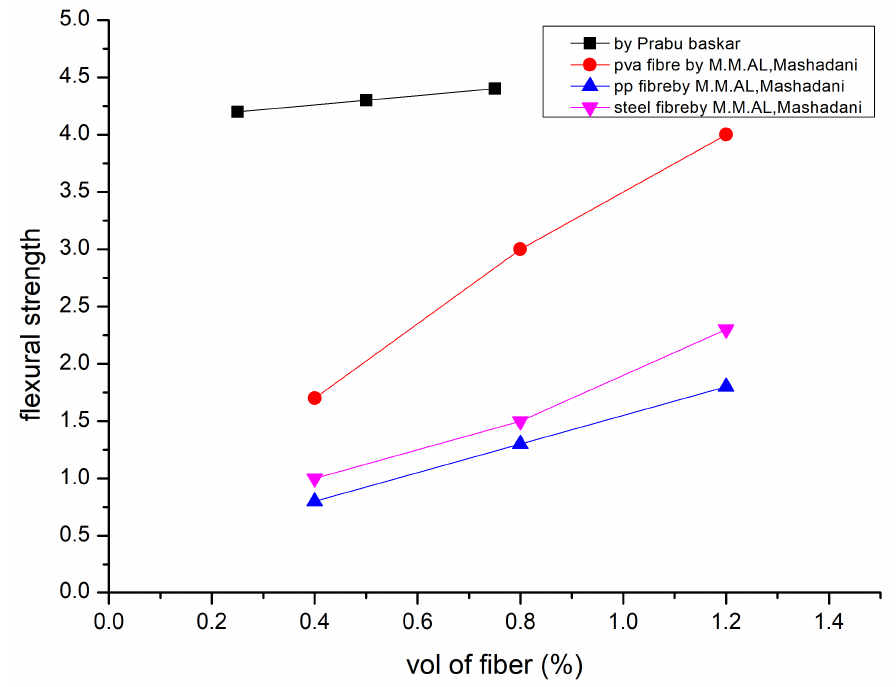
Figure 7. Flexural Strength [10,89,115].